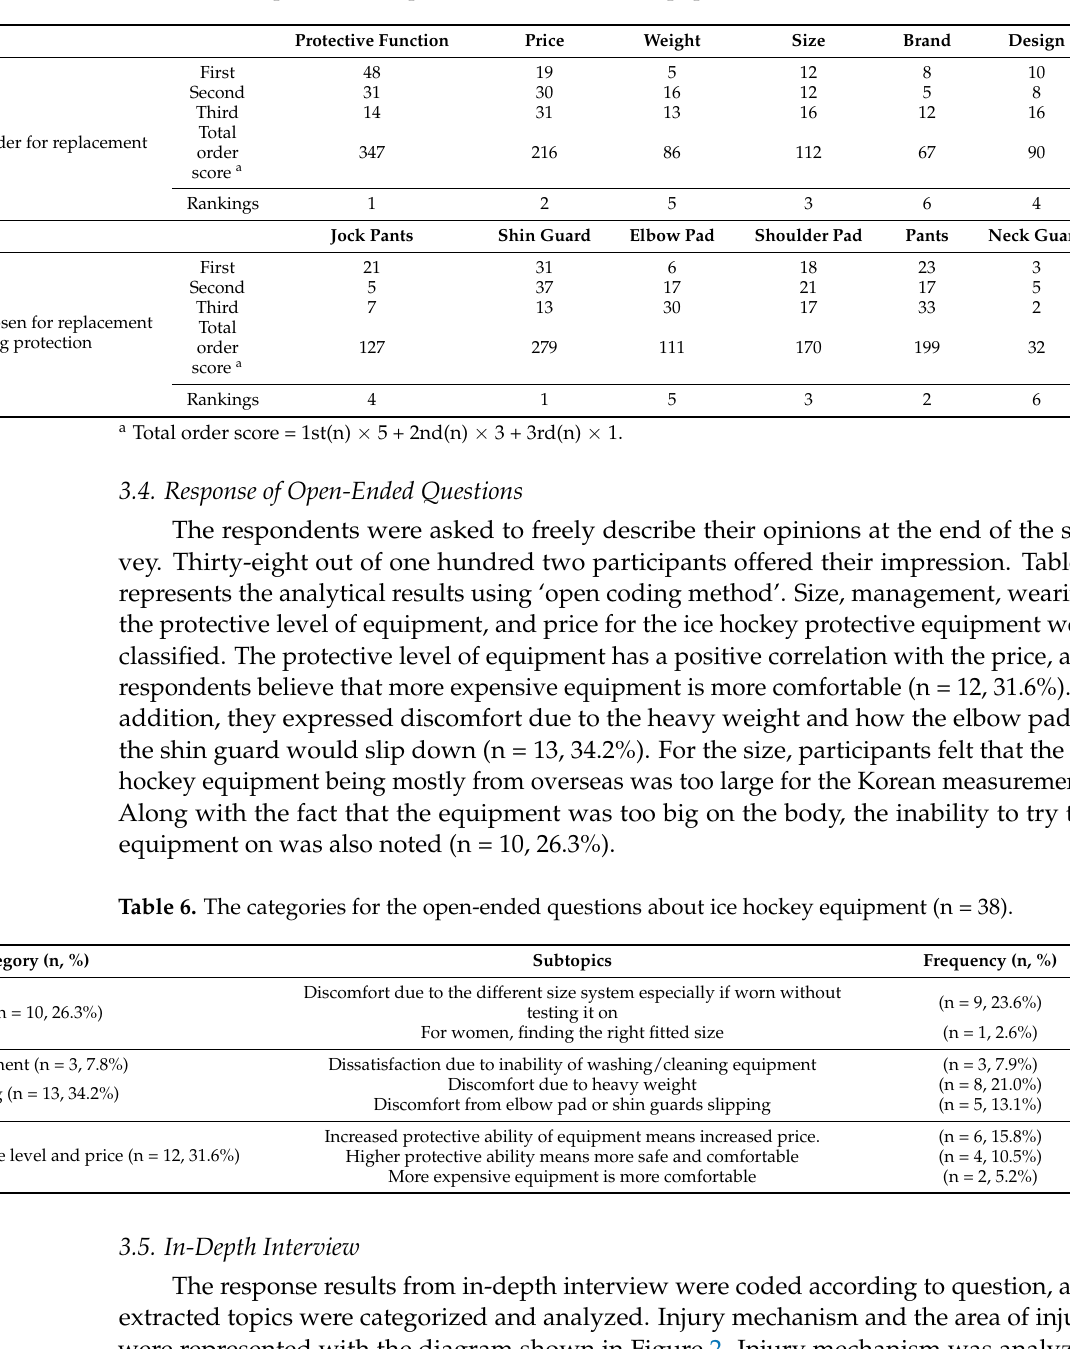
Table 5. The Aspect of the Replacement of Protective Equipment.